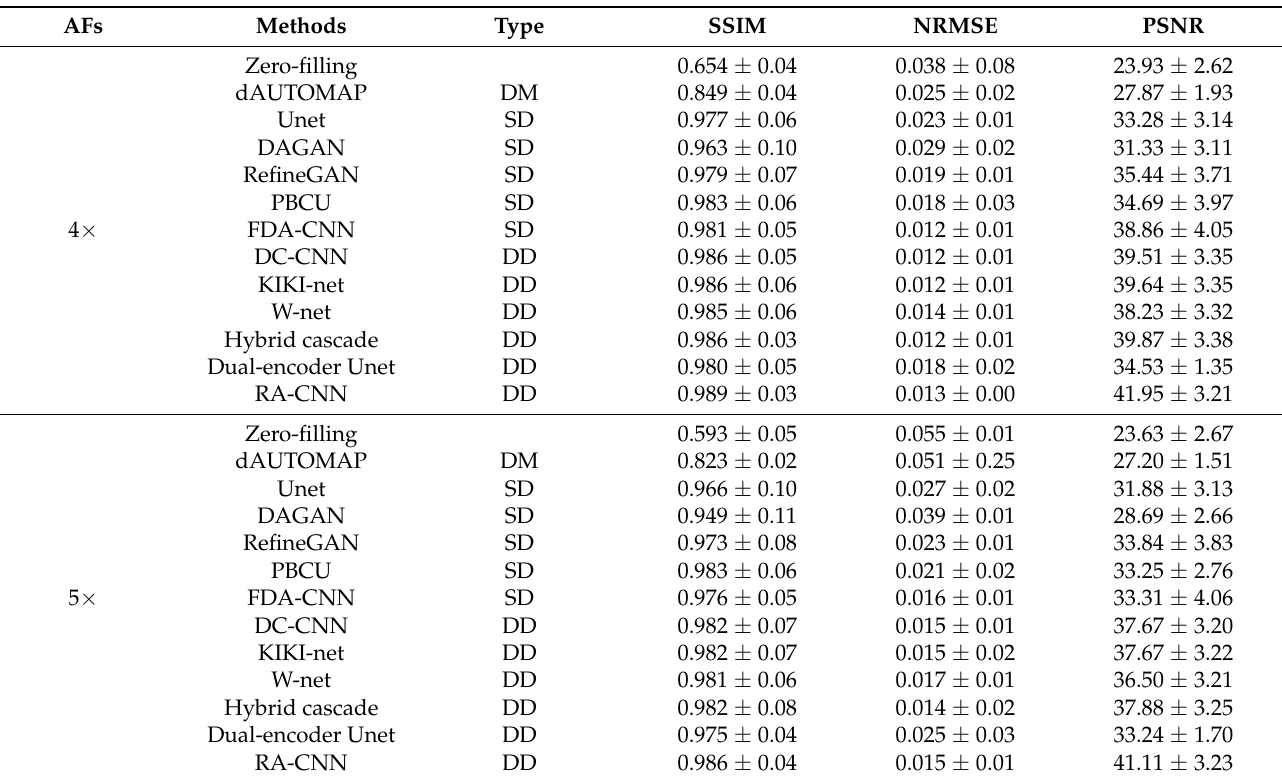
Table 1. Mean ± standard deviation SSIM, NRMSE, and PSNR values obtained using the state-of- the-art methods with different